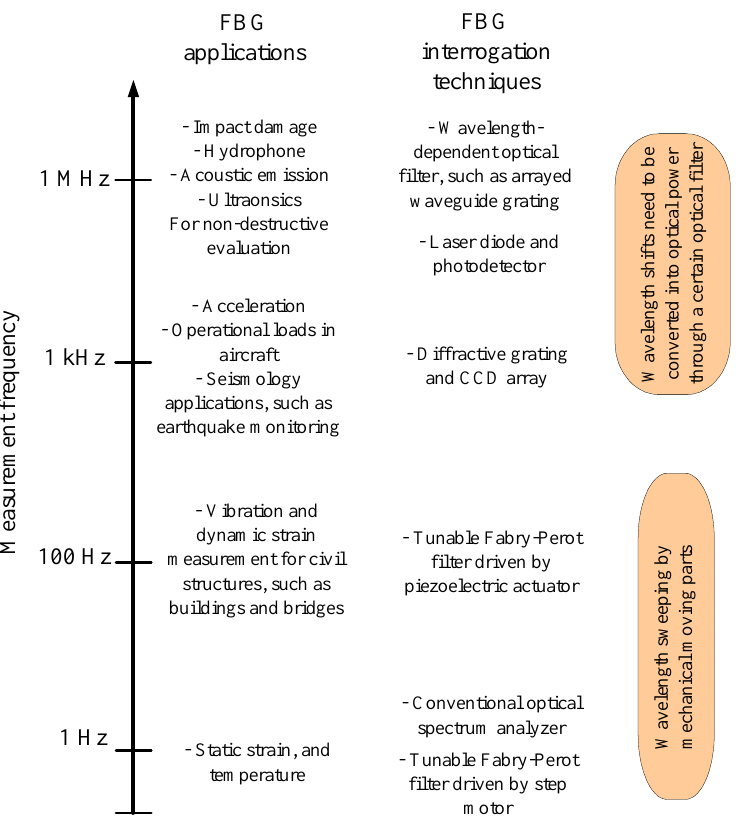
Figure 6. FBG interrogation methods classified by measurement